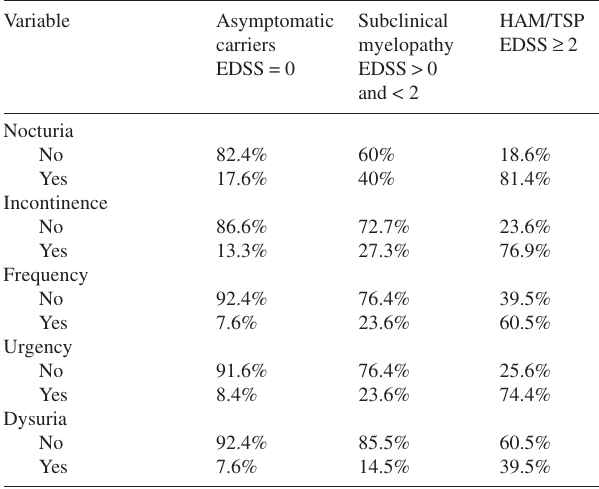
Table 1 - Urinary symptoms in patients with HTLV-I Variable Asymptomatic